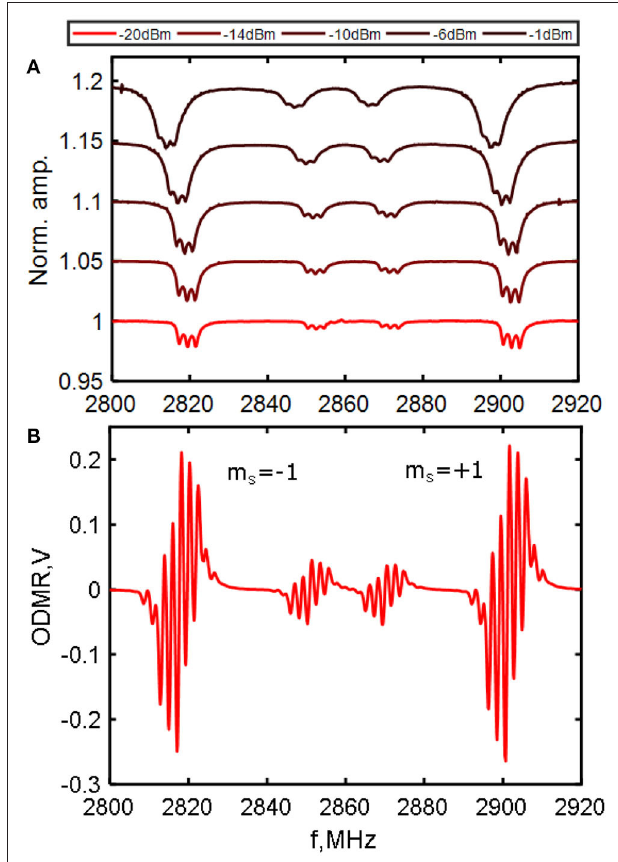
FIGURE 2 | ODMR from our diamond sample. The 14 N diamond was 12 C enriched with 20 µ m of CVD overgrowth, then proton irradiated with N concentration 5 ppm. (A) Normalized change in DC photovoltage with 2 W ≈ pump power (max 6.5 mW fluorescence) at a range of microwave input powers, each offset by 0.05. A 1.6 mT offset field was applied with fine ≈ adjustment from field coils to overlap 2 NV axes and boost contrast to a maximum of 5.1%. Due to microwave broadening and resulting loss of the hyperfine features, actual peak sensitivity is reached at a lower 3.8% contrast. The downward frequency shift observed is due to heating by the microwave field. (B) ODMR at peak sensitivity using a 33 kHz MW frequency modulation of 500 kHz mixed with a 2.16 MHz hyperfine transition drive (see method details in the work by El-Ella et al. [ 33]). This boosts sensitivity to 100 pT/ √ Hz . Linewidth FWHM is 1 ∼